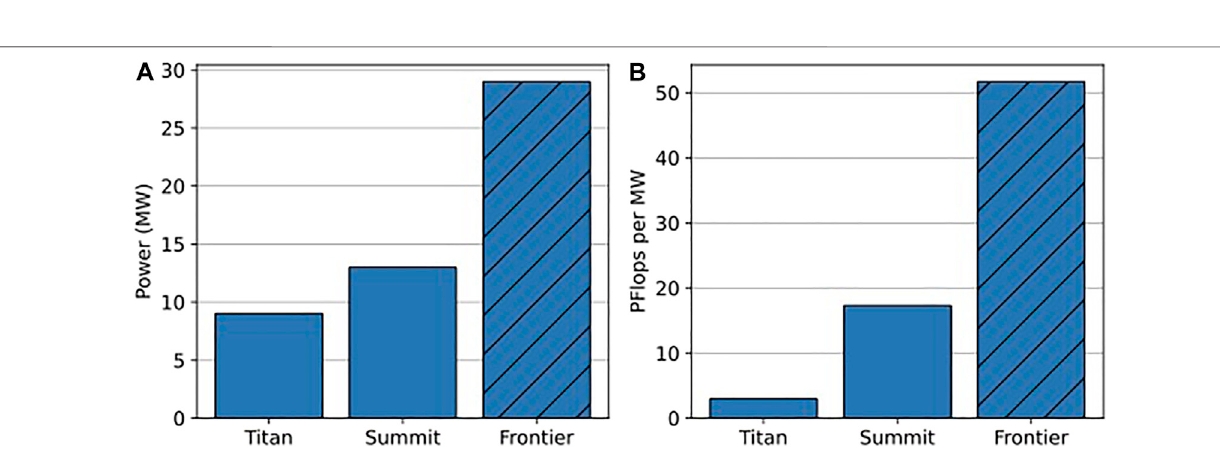
Frontiers in Physics |